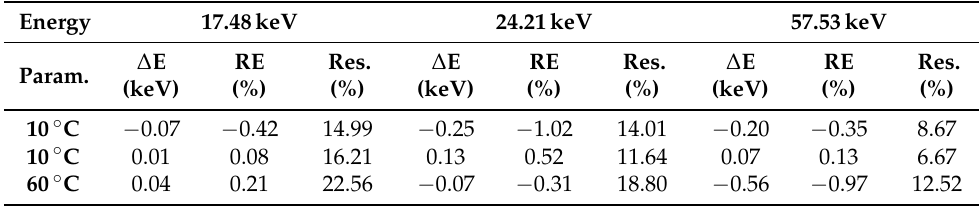
Table 4. Temperature influence on radiation energy measurement with 500µm silicon MiniPIX Timepix3 detectors in Time-over-Threshold mode after application of the proposed individual correc- tion method. Where ∆ E is the absolute measurement accuracy, RE is the relative error of measurement, and Res. is the relative energy resolution.